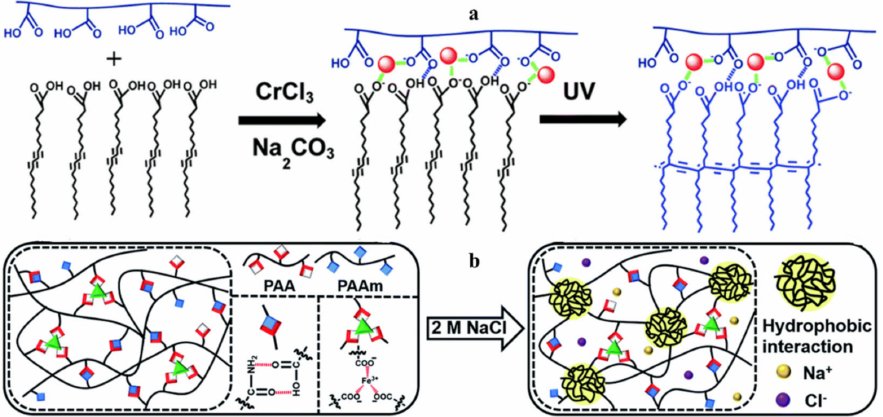
Figure 51. ( a ) Synthesis of the polydiacetylene–PAA–Cr 3 + elastomer. The PAA network is shown in green, and diacetylene monomers and polydiacetylene are shown in black and blue, respectively. The red spheres correspond to the Cr(H 2 O) 6 3 + complex. Reproduced from [222] with permission from The Royal Society of Chemistry. ( b ) Schematic representation of the process of preparing self-healing hydrogels. Reproduced from [223] with permission from The Royal Society of